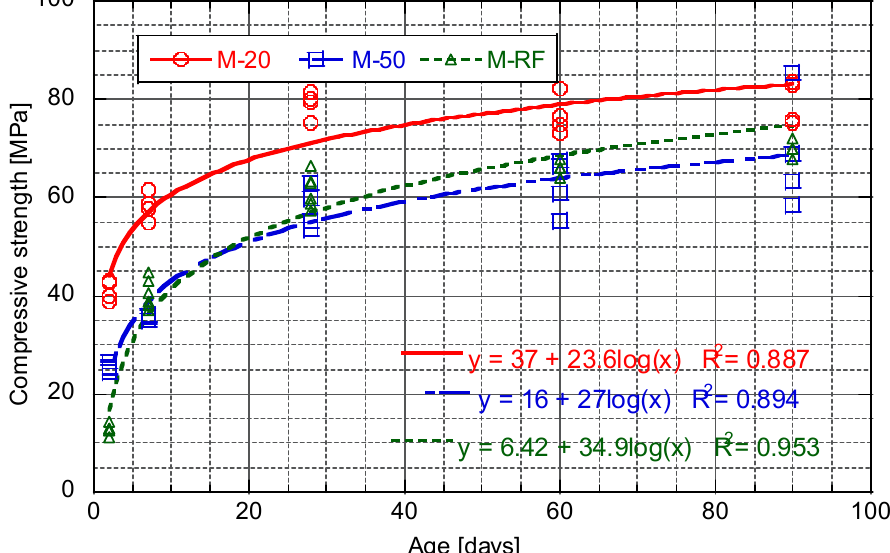
Figure 16. Evolution of the compressive strength as function of time.